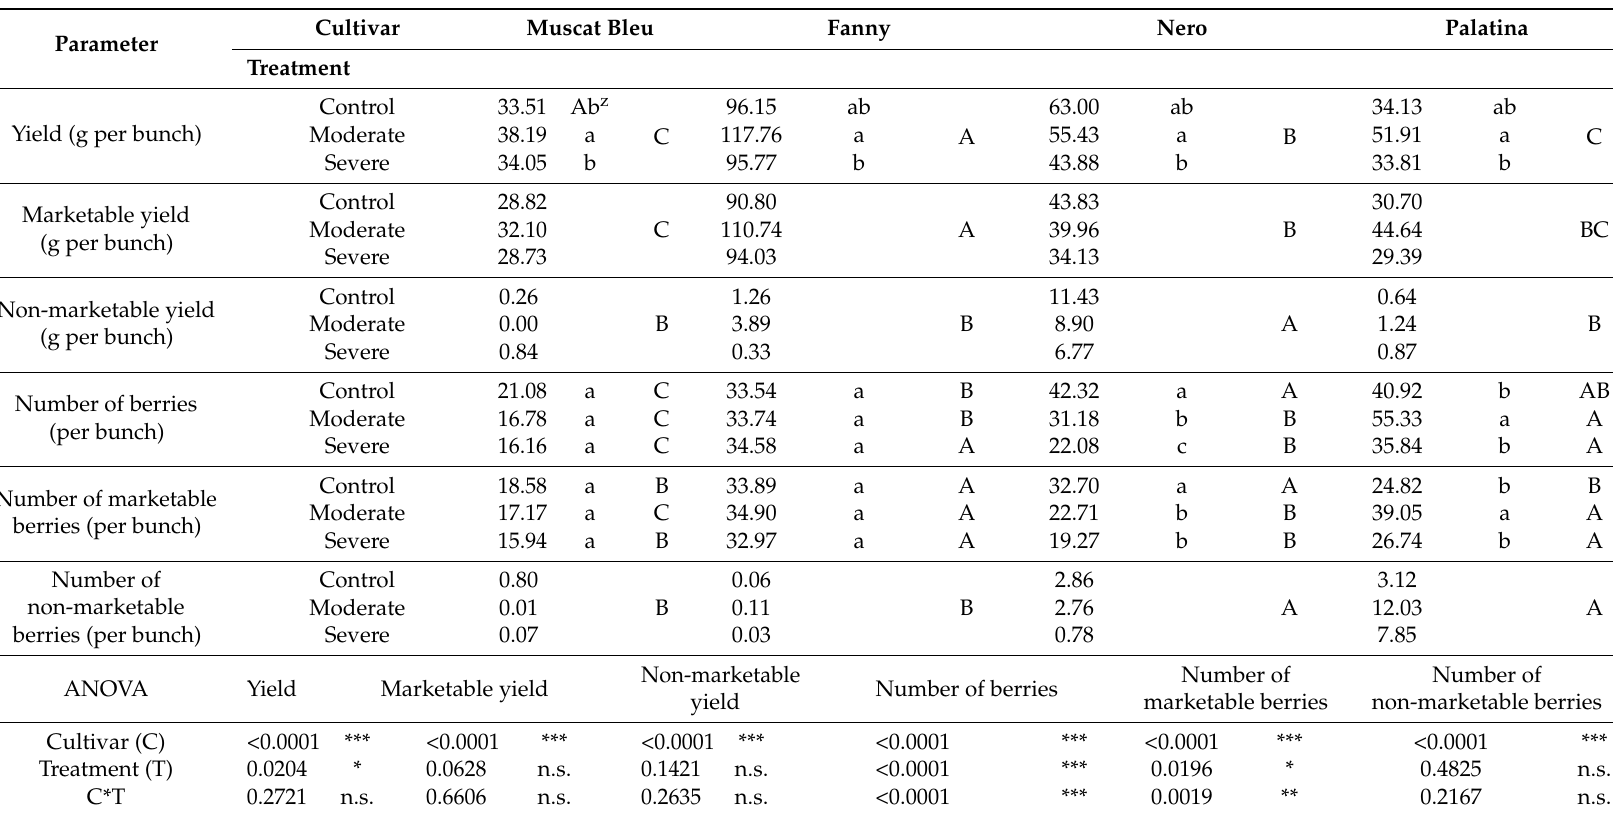
Table 2. Table grape parameters on the bunch level: Yield, marketable and non-marketable yield, number of berries, and number of marketable and non-marketable berries of four three-year-old table grape cultivars under three water deficit treatments in